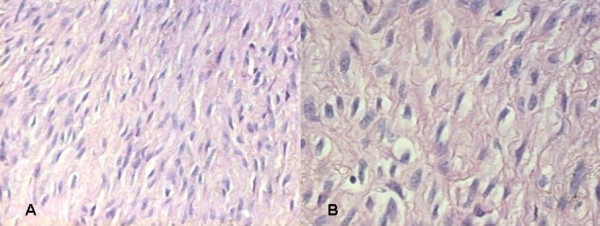
Photomicrographs in (A) low-power and (B) high-power show elongated, slender, spindle-shaped cells of uniform appearance without atypia. The cells are surrounded and separated from one another by abundant collagen, with little to no cell-to-cell contact.